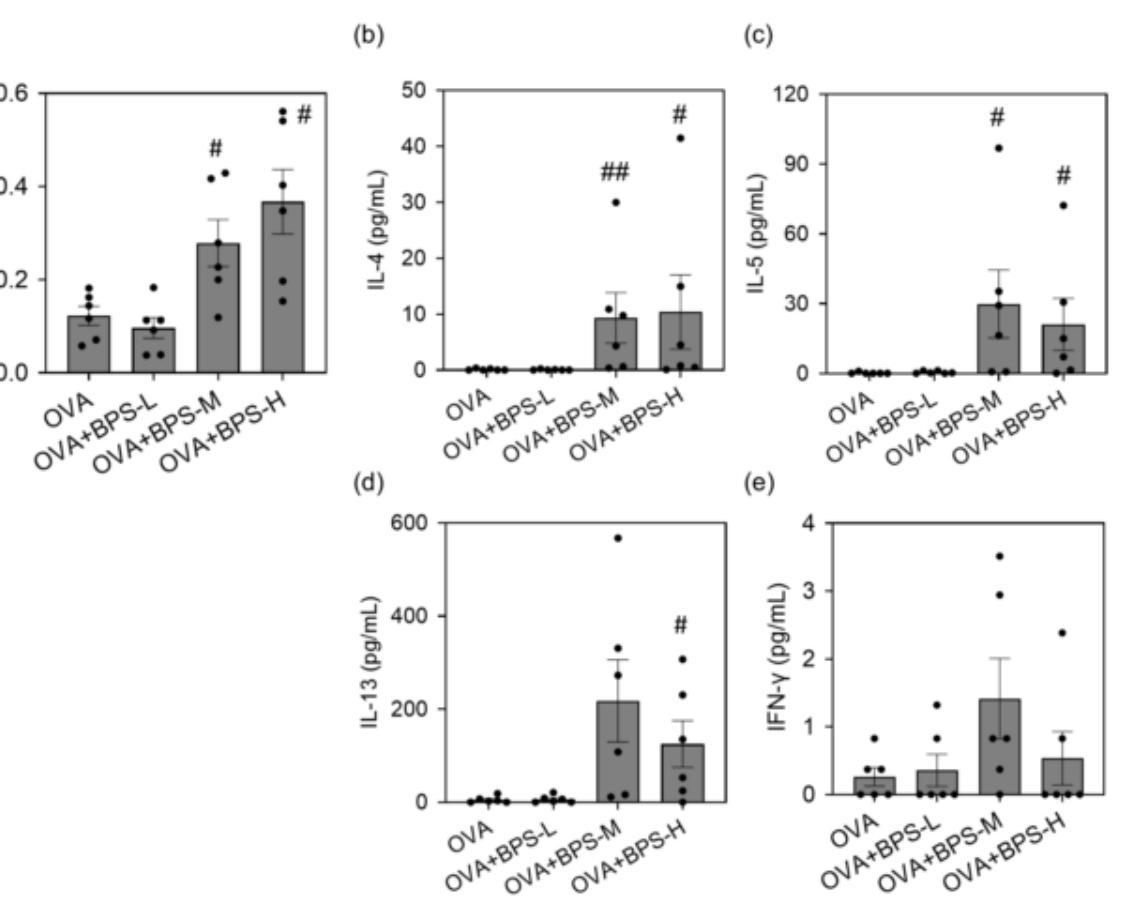
Figure 9. Activation of MLN cells. MLN cell proliferation and cytokine expression in the culture supernatant were analyzed 91 h after OVA restimulation. ( a ) Cell proliferation (Abs). ( b ) IL-4. ( c ) IL-5. ( d ) IL-13. ( e ) IFN- γ . Data are expressed as mean ± SE of 6 animals per group. # p < 0.05 vs. OVA group, ## p < 0.01 vs. OVA group. IFN, interferon; IL, interleukin; MLN, mediastinal lymph node; OVA, ovalbumin; SE, standard error.